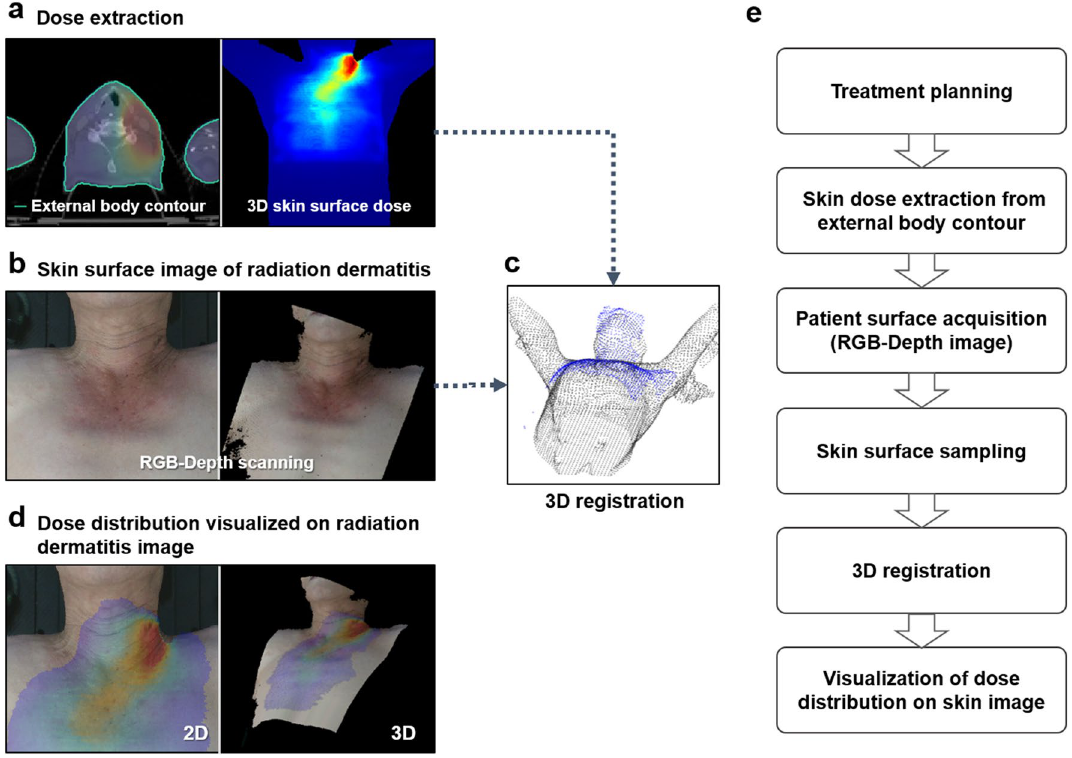
Figure 3. Schematic diagram demonstrating the methodological workflow of the radiation dose-toxicity evaluation system (RaTES). ( a ) Treatment plans are exported in DICOM-RT format for each patient. The 3D skin dose (3DSD) is automatically extracted through the RaTES using RT plan, RT dose, and external body contour, and it is calculated as the cumulative dose of the treatment fractions until 3D skin surface image (3DSSI) is obtained. ( b ) The 3DSSI data of the patients are scanned in the treatment position using an RGB- depth camera, which can simultaneously scan color and depth images. ( c ) Both 3DSD and 3DSSI are registered using an iterative closest point algorithm based on the form of the point cloud dataset. ( d ) The registration outcome is visualized as a 3D surface and a 2D projection image. ( e ) Schematic overview of the workflow conducted in this